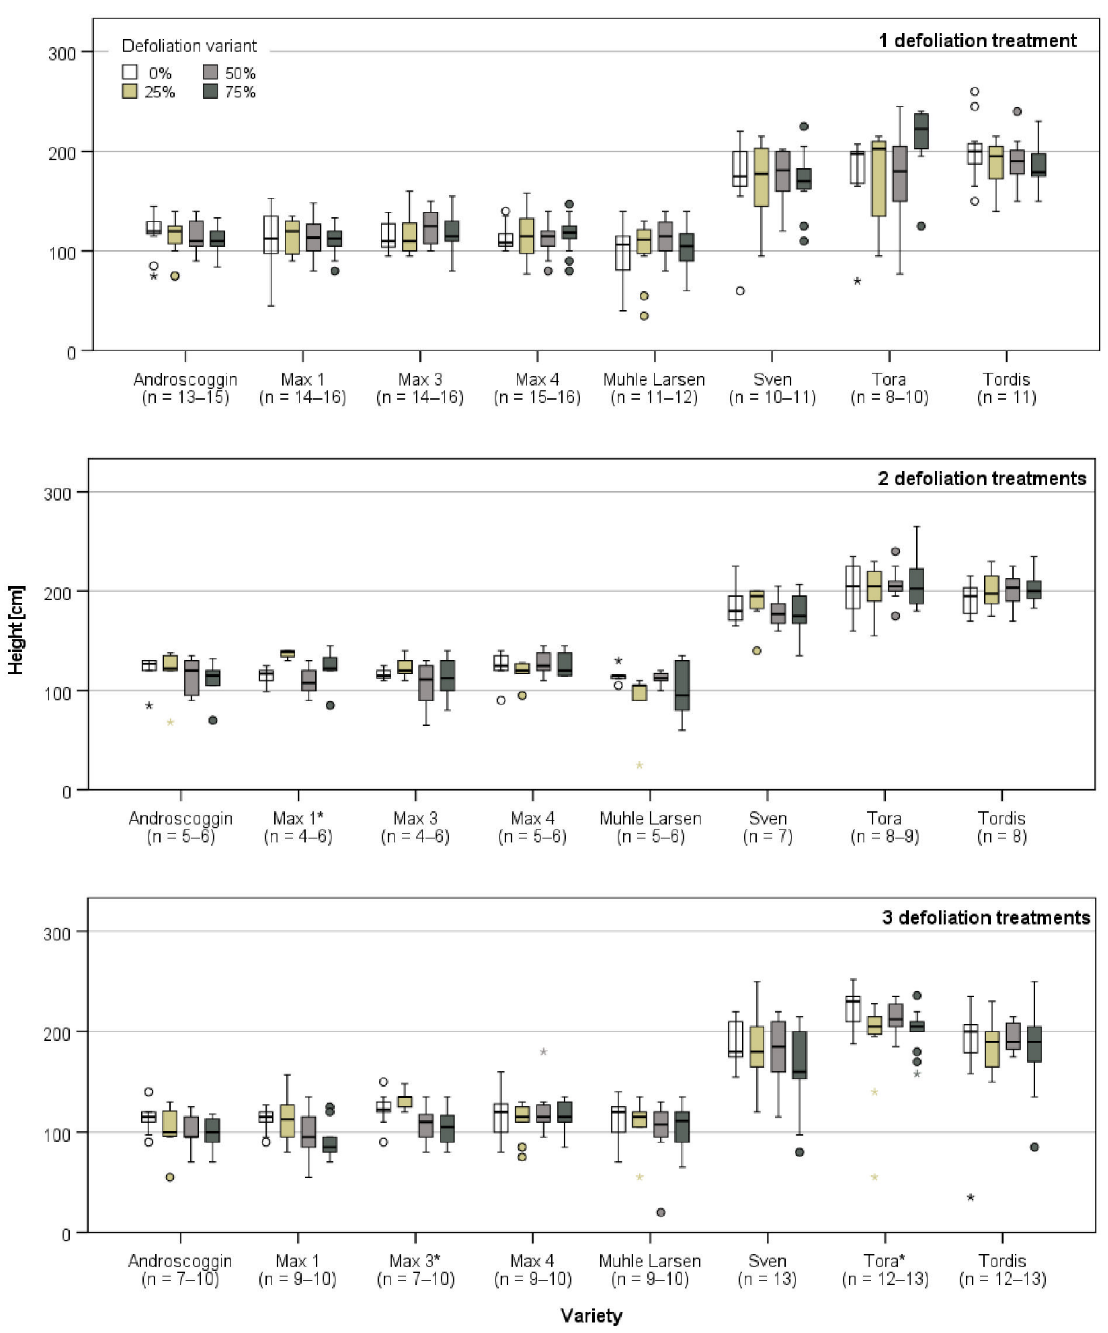
Figure A3. Height of poplar and willow varieties on the study site in Großthiemig in June 2009 after a harvest of the short rotation coppice in March 2009 with regard to the number of defoliation treatments and the defoliation treatment variant in 2007 and 2008 (n = range of number of plants per defoliation variant, * statistically significant difference according to ANOVA).